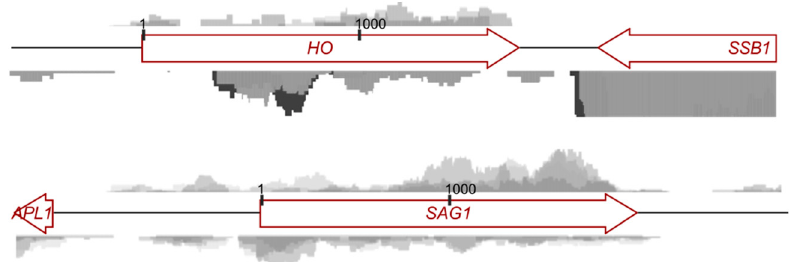
Figure 5. Antisense transcripts corresponding to HO or SAG1 co ‐ exist in spores. As in Figure 4a, RNA ‐ seq reads from sorted spores were mapped to regions of the genome surrounding the HO or SAG1 gene. Note that for the HO gene the scale was set the same for the sense and antisense reads mapping to HO , but at this scale most reads from the adjacent, highly ‐ expressed SSB1 gene exceed this scale.